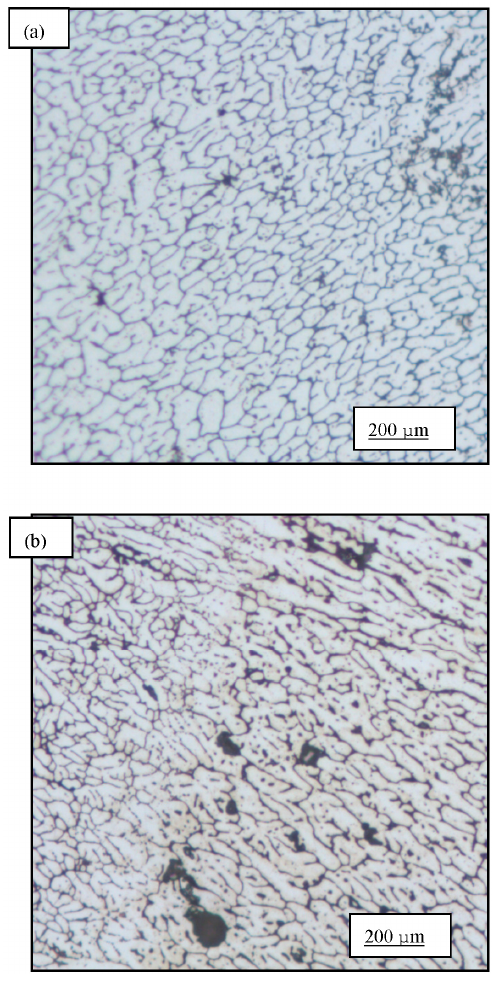
Figure 4. Optical micrograph of the weld pool showing fine grains of varying size and shape. ( a ) Grain size and morphology in the weld pool in the as-welded condition; ( b ) weld pool in the post weld heat-treated condition.